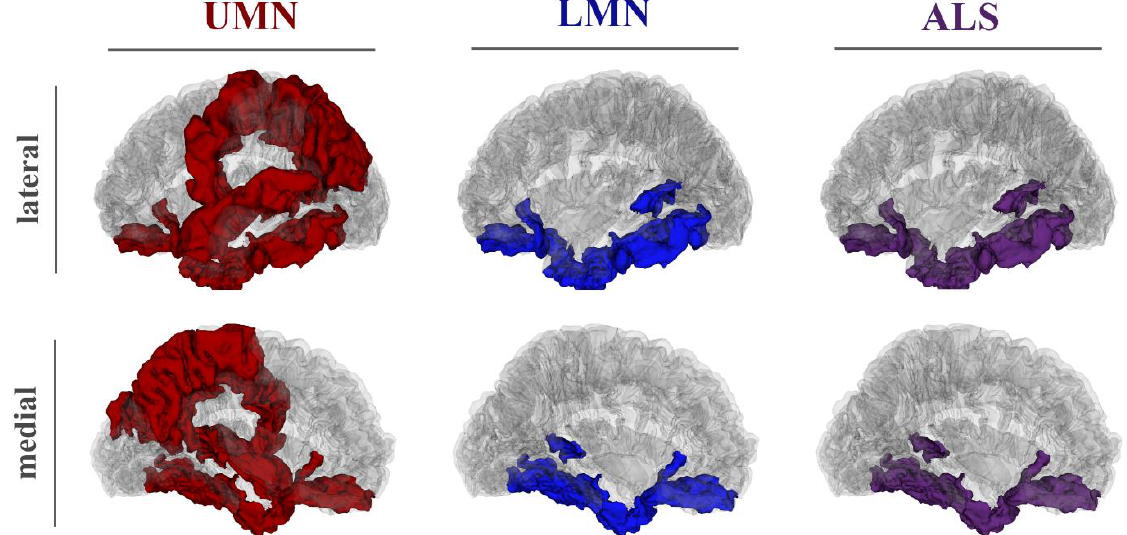
Figure 2. Differences in cortical thickness. Brain regions of the left hemisphere showed differences in cortical thickness compared to healthy controls identified using the Quade test plotted on a transparent MNI-template. Differences are shown either in red (UMN vs. HeaCON), in blue (LMN vs. HeaCON) or in violet (UMN and LMN vs. HeaCON). MNI, Montreal Neurological Institute; HeaCON, healthy controls; LMN, lower motor neuron patients; UMN, upper motor neuron patients. In contrast, the reduced thicknesses of the precentral and paracentral gyrus, precu- neus, superior parietal lobule and superior temporal gyrus were observed only in patients with UMN compared to in patients with LMN and HeaCON. Furthermore, a CT reduction for UMN compared to for HeaCON was found within the inferior parietal lobule, without a significant difference between the two ALS groups (Figure 2, left). For further infor- mation regarding CT and statistical results, see Table 3. Table 3. Statistical results (descriptive, univariate) of cortical thickness from 34 different cortical regions of the left hemi- sphere in HeaCON, LMN and UMN. Significances were Bonferroni-corrected for multiple comparisons. HeaCON, healthy controls; LMN, lower motor neuron patients; UMN, upper motor neuron patients. Localization